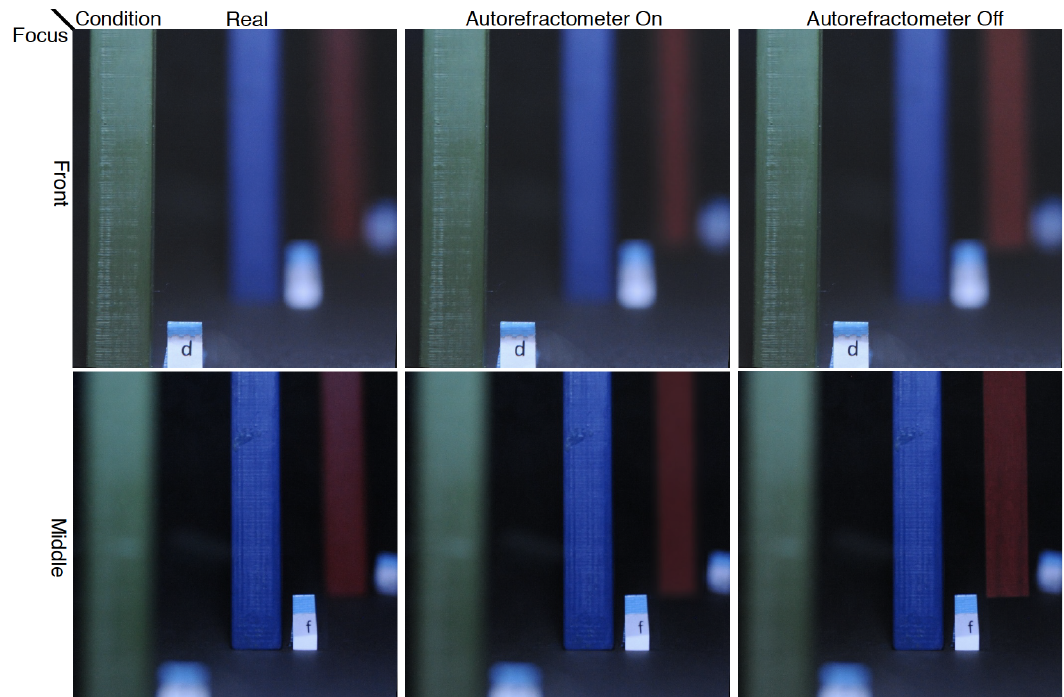
Figure 2. Participants’ view during the experiment for two different focus distances (front: green pillar, middle: blue pillar). The green and blue pillars are real; the red pillar is only real in the leftmost column. Note how the red pillars in columns Real and Autorefractometer On closely match. For comparison, column Autorefractometer Off shows views similar to most OST AR displays; note the mismatch compared to the red pillars in the other